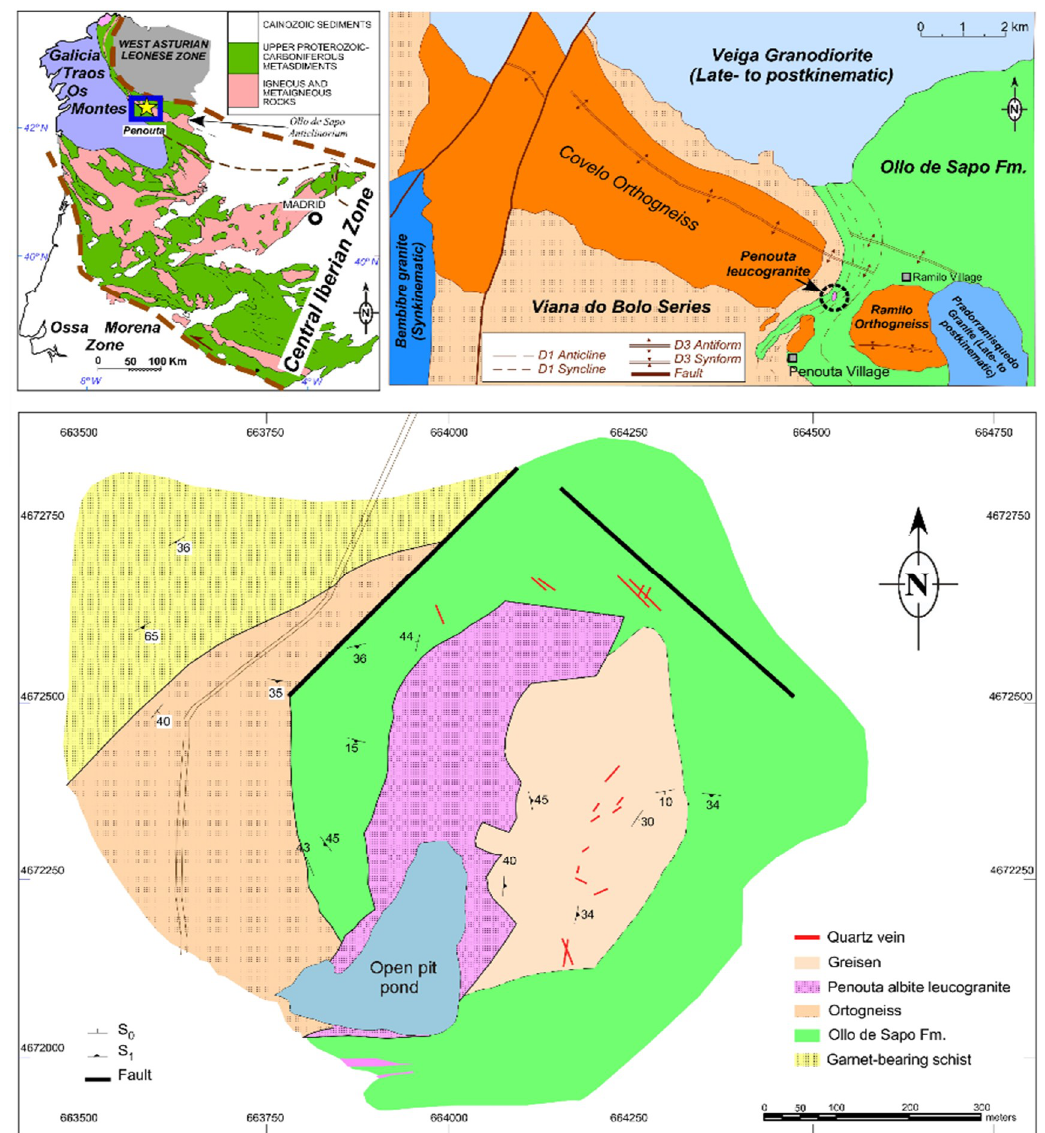
Figure 1. Location of the Penouta deposit. Upper left: geological map of the Central Iberian Zone with the location of the Penouta deposit. Upper right: geological sketch of the Ollo de Sapo Anticlinorium with the location of the Penouta leucogranite. Lower part: detailed geological map of the Penouta deposit (modified from [42]).